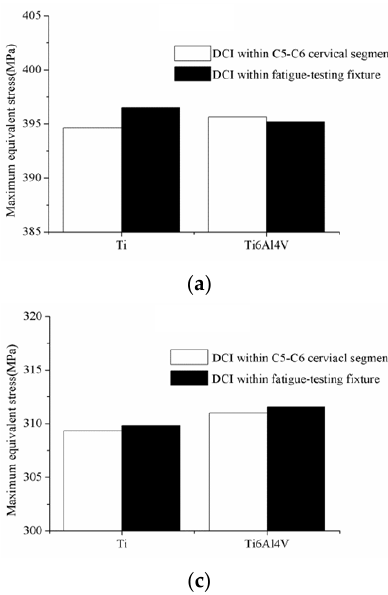
Table 2. Simulated fatigue results and fatigue-testing results.